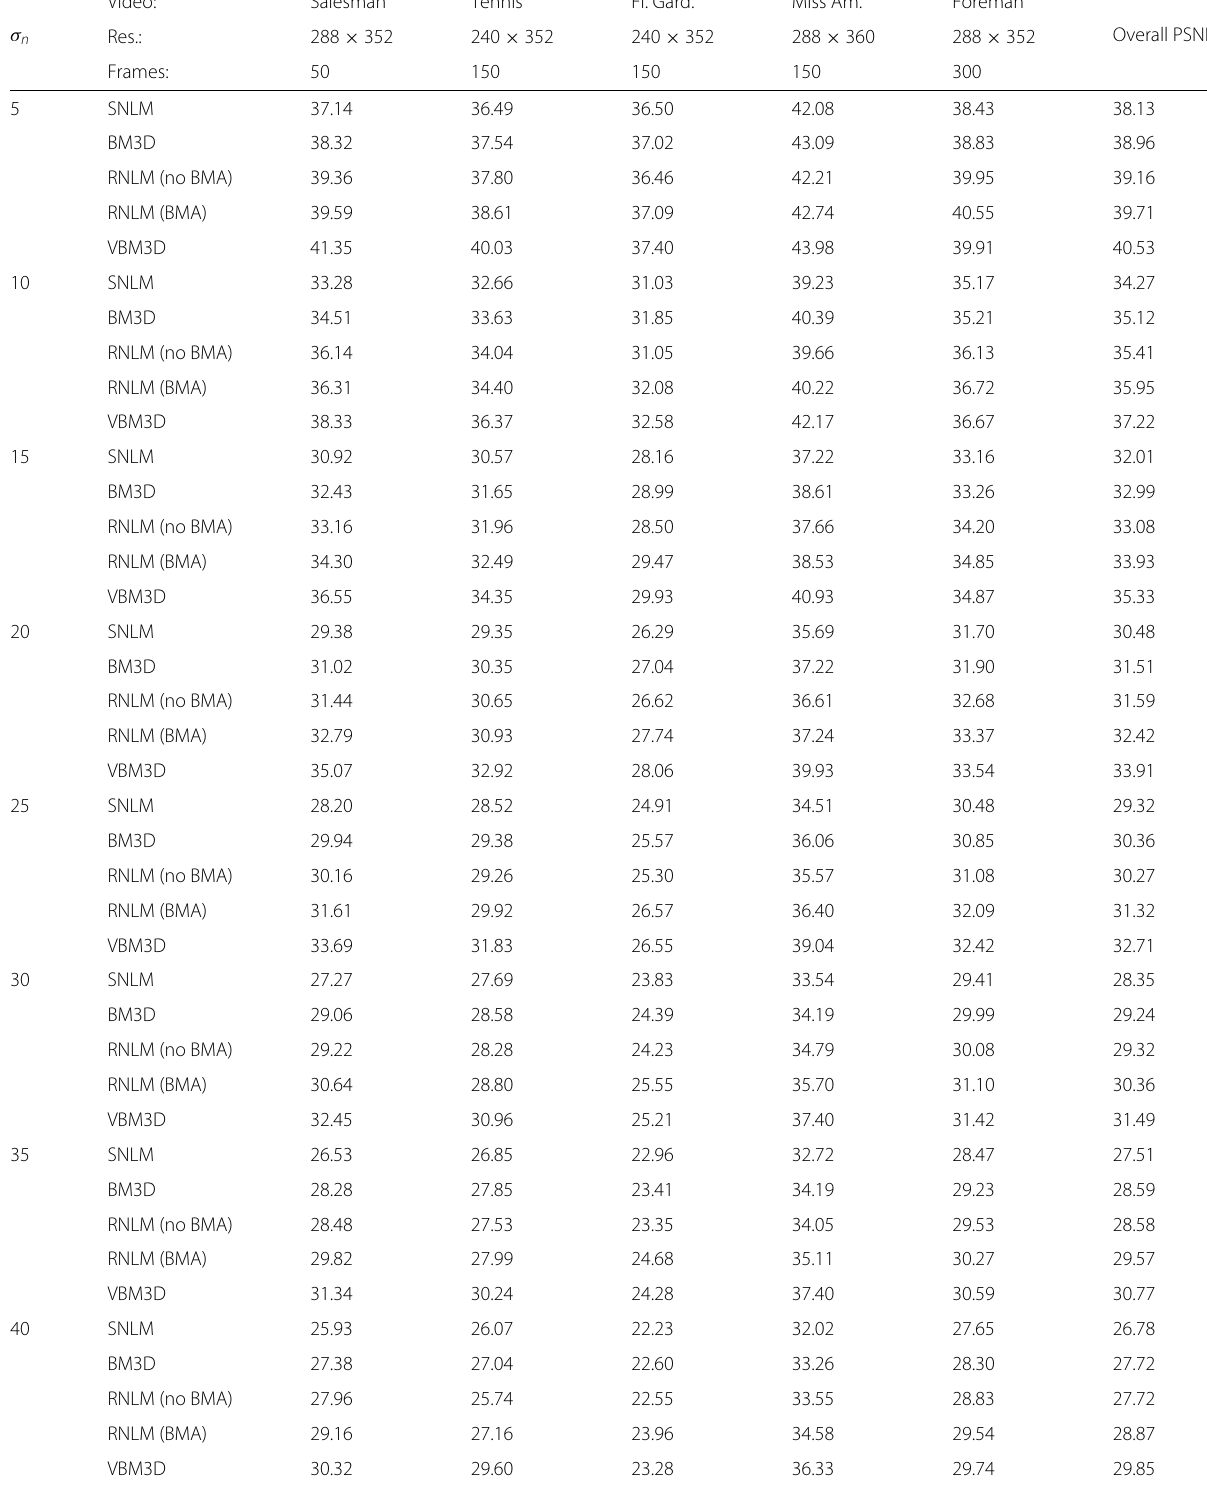
Table 2 PSNR comparison with competitive denoising algorithms using five different sequences and eight noise standard deviation